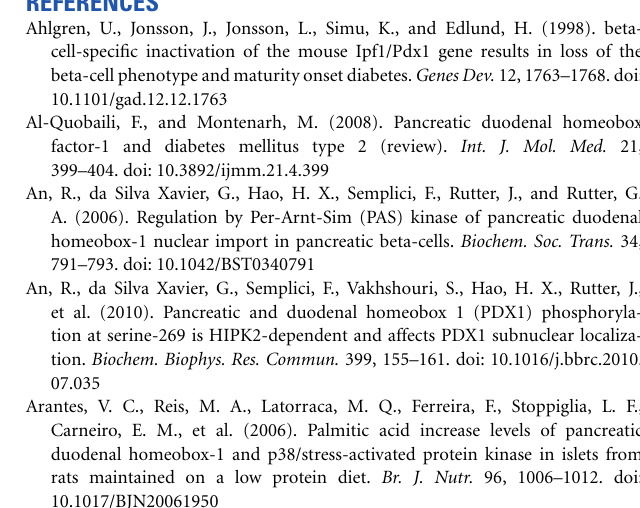
to stabilization of PDX-1 by inhibiting PDX-1 ubiquitination. SSTR5-mediated somatostatin (SST) signaling inhibits EGF signaling by inhibiting small G protein